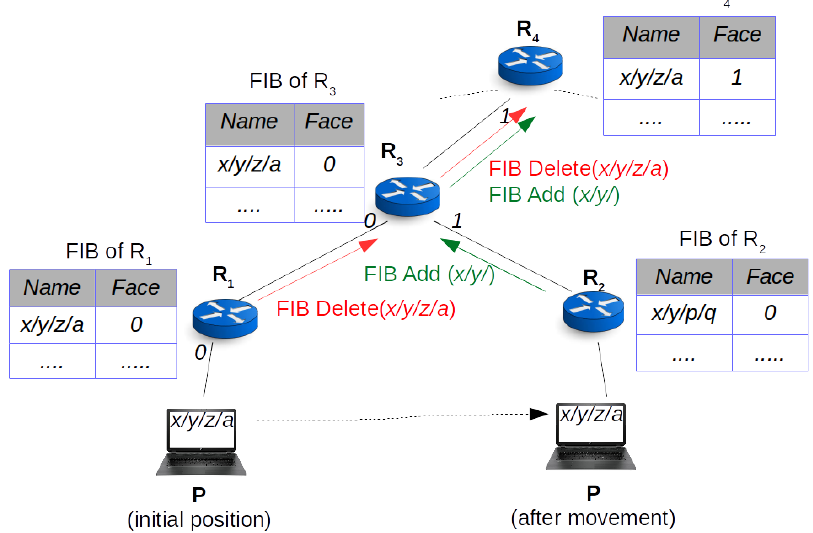
Figure 2. FIB updates to common upstream router (Case